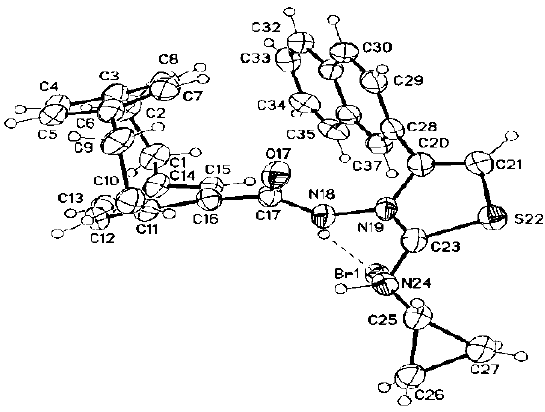
Figure 4. Molecular structure of compound 9 identified according to IUPAC nomenclature as 3- (1,4(1,4)-dibenzenacyclohexaphane-1 2 -carboxamido)-2-(cyclopropylamino)-4-(naphth-2-yl)thiazol-3- ium